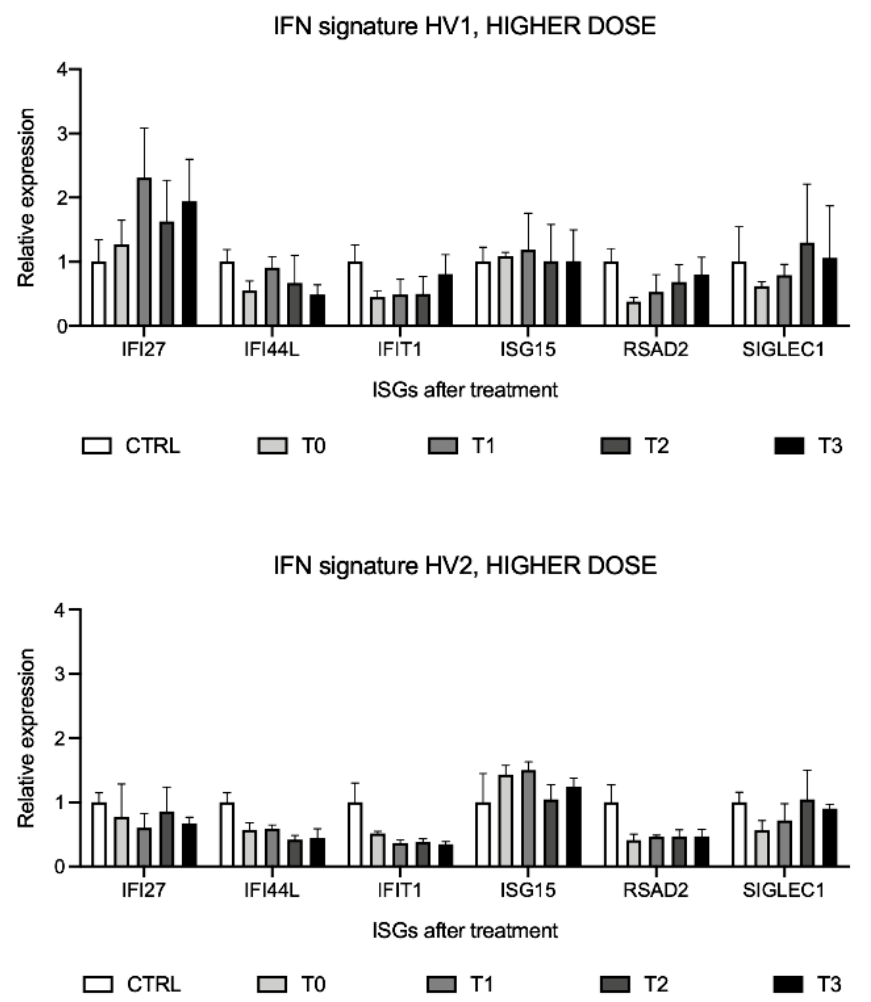
Figure 9. Interferon signature analysis in two healthy volunteers (HV1, HV2) after sulforaphane (SFN) supplement consumption at 90 mg/day for three days, displayed as the expression levels of the six interferon-stimulated genes (ISGs). Data are shown as means and C.I. of one representative experiment and reported evaluating 2 − ∆∆ Ct values considering a pool of healthy volunteers’ cDNAs as calibrator and using HPRT1 and G6DP housekeeping genes as reference.